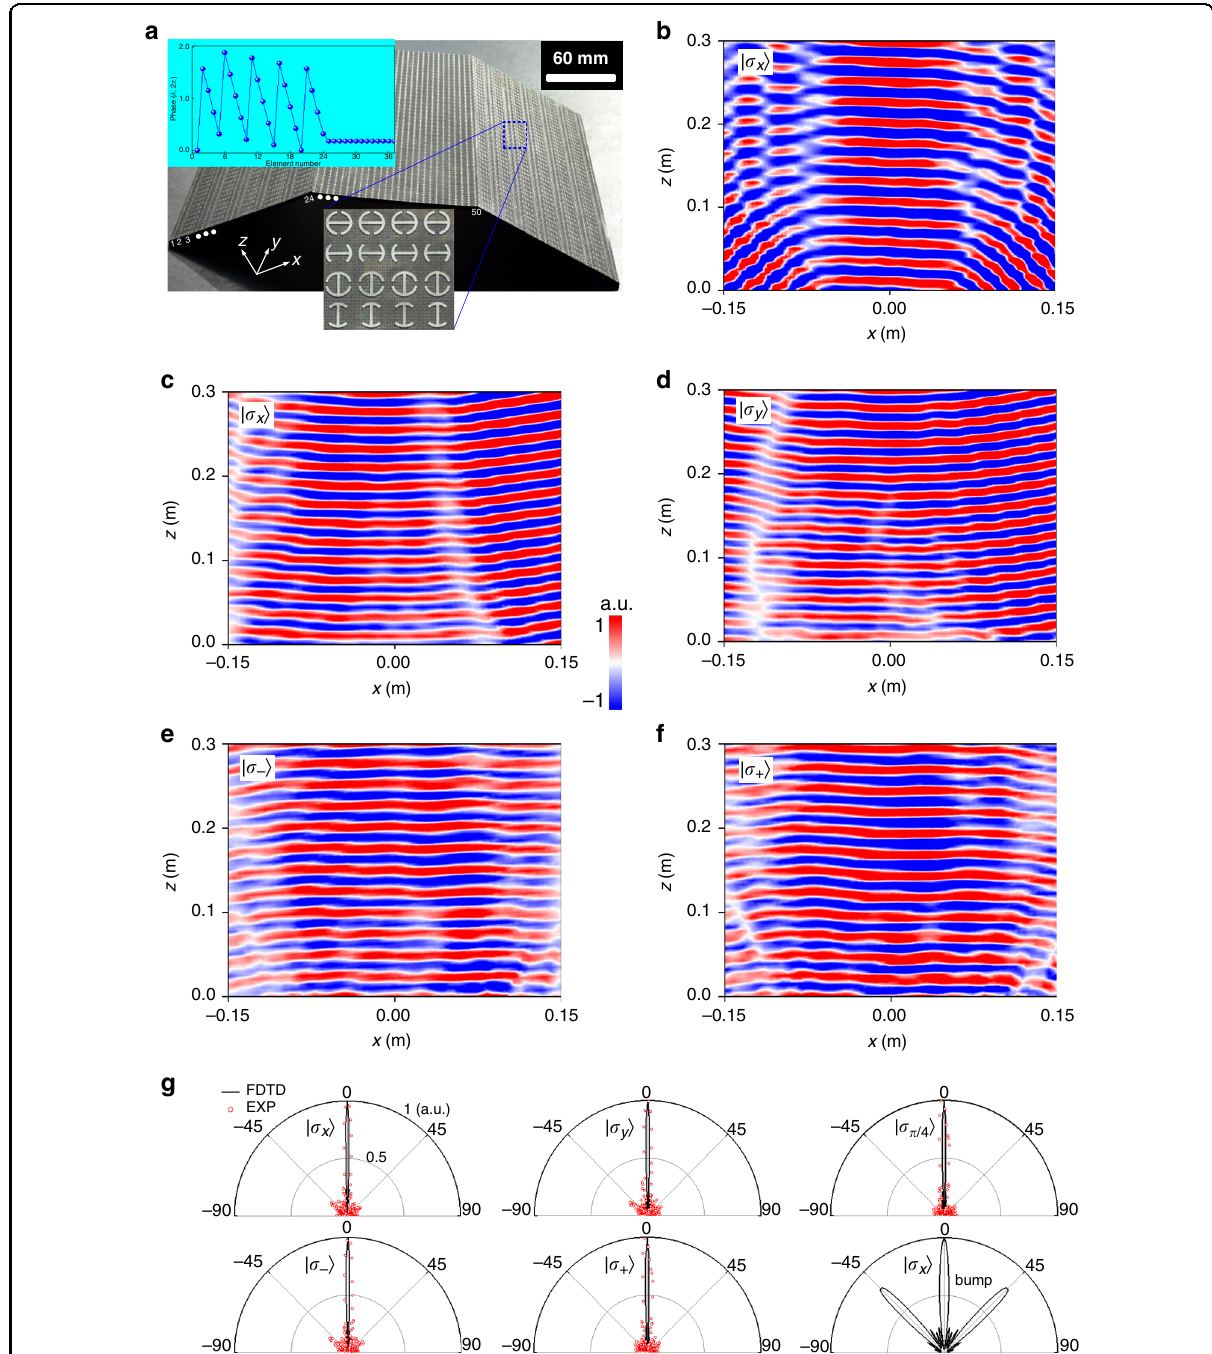
planes under fi ve representative polarization states of normally incident plane EM waves. Elegant cloaking performance can be also expected at other azimuthal planes, except for the above two principal planes.